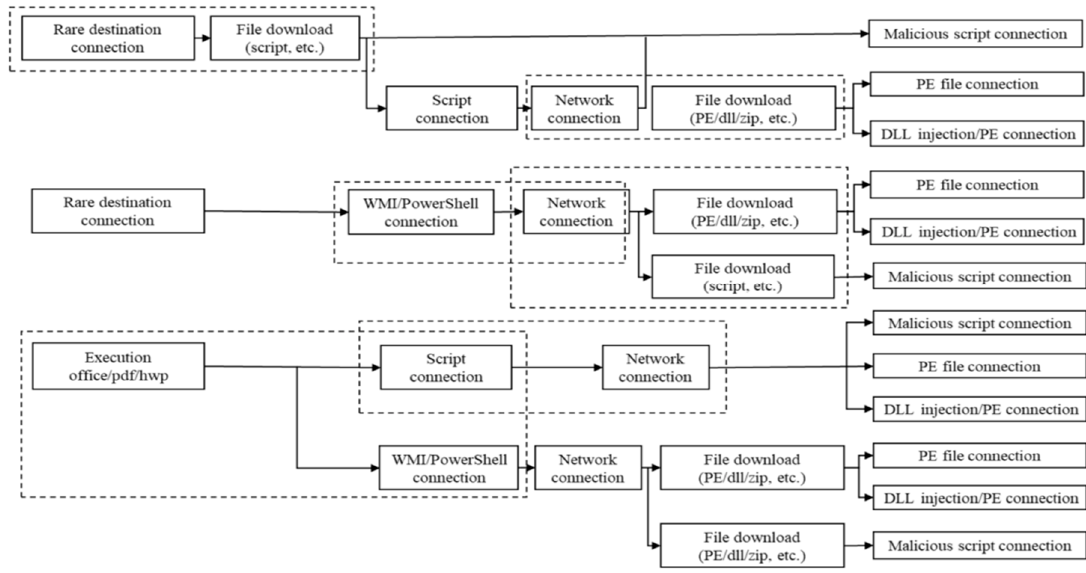
Figure 8. Main attack scenario in the attack profile.